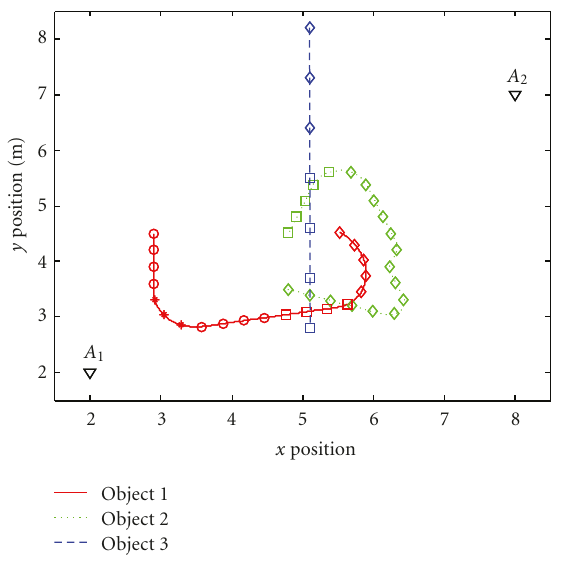
Figure 17: Three objects trajectories and the positions of the two acoustic